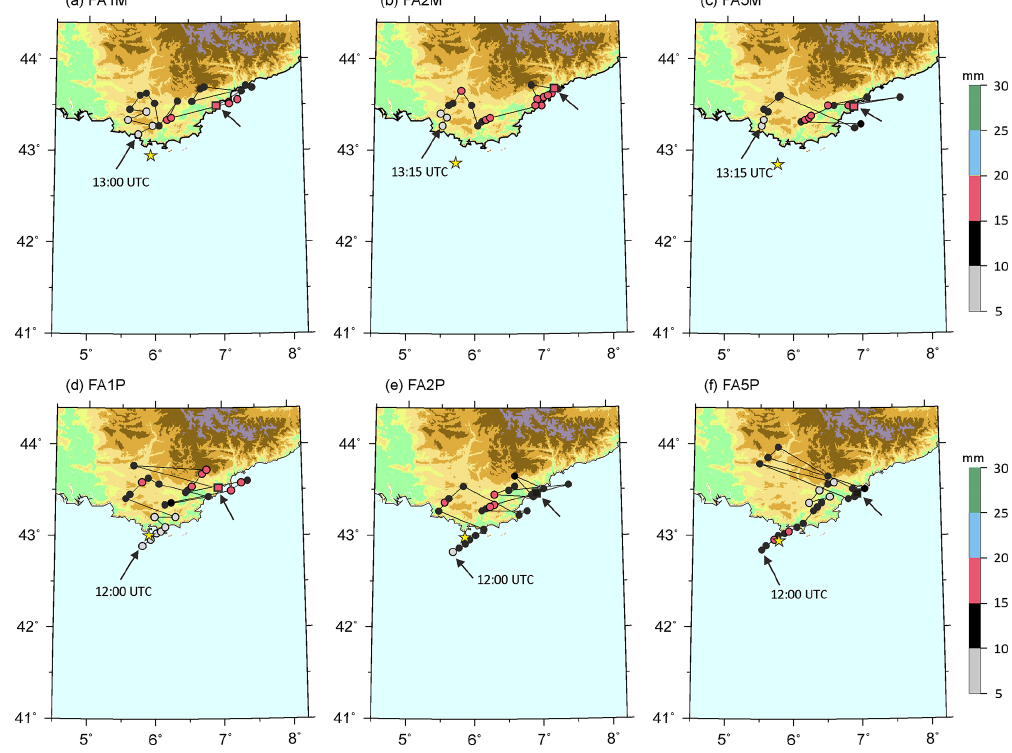
Figure 14. Same as Fig. 8 for (a) FA1M, (b) FA2M, (c) FA5M, (d) FA1P, (e) FA2P, and (f) FA5P.